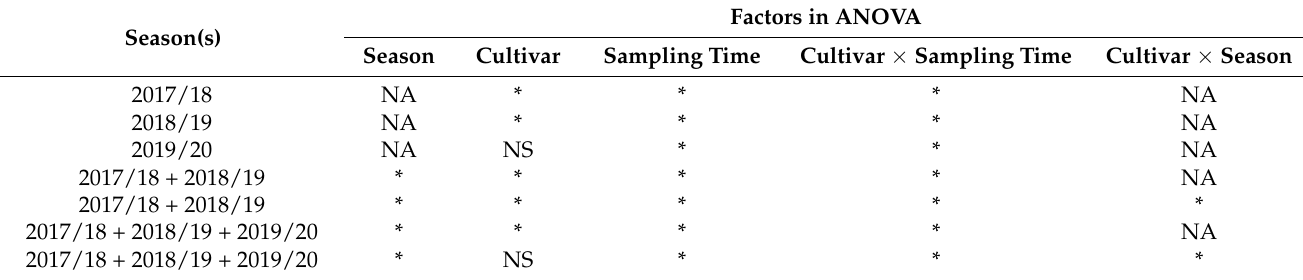
Table 2. Modeling cultivar, sampling time, season, and cultivar by sampling time and/or season interaction contributions to the low temperature